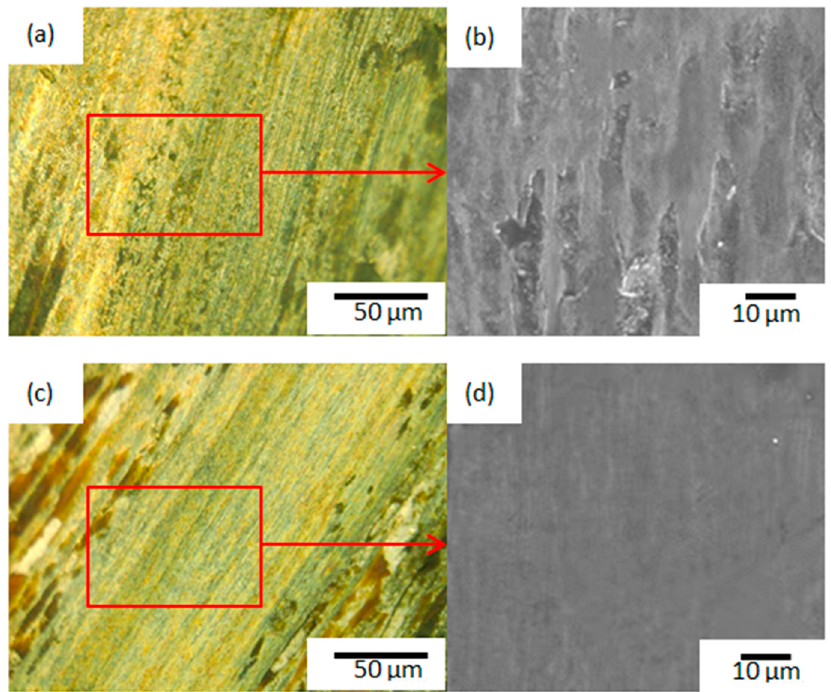
Figure 12. Wear morphology of Samples A and B. ( a , b ) The overall morphology and local magnification of the wear scar of Sample A; ( c , d ) the overall morphology and local magnification of the wear scar of Sample B.